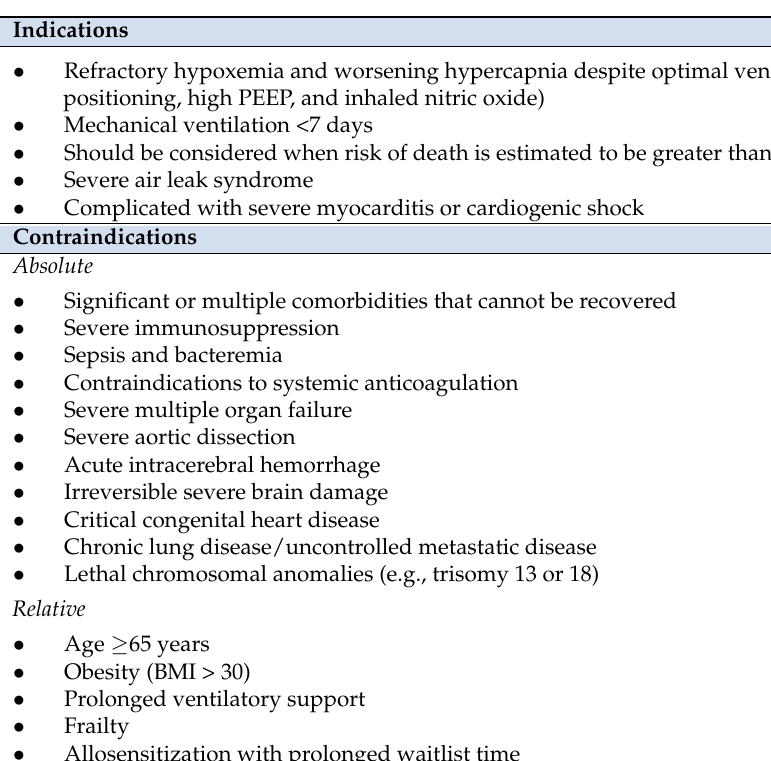
Table 4. Indications and contraindications for ECMO use in COVID-19